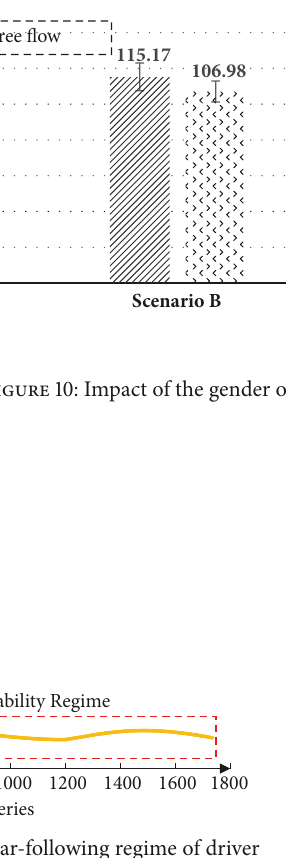
Figure 11: Compartmentalization of car-following regime of driver